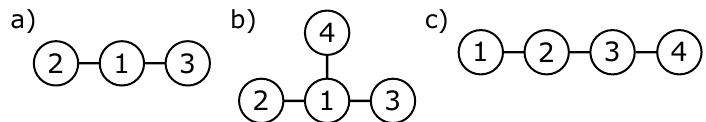
Figure 15: Examples of connectivity graphs in ˆ S z -basis for different fragments, cor- responding to the Hamiltonians (15). Graphs (a) and (b) possess permutation sym- metry: graph (a) does not change upon the exchange of states 2 and 3, (b) does not change upon any permutation of states 2,3,4. As a result, the corresponding Hamilto- nians contain (a) two, (b) three equal columns (rows), which results in them